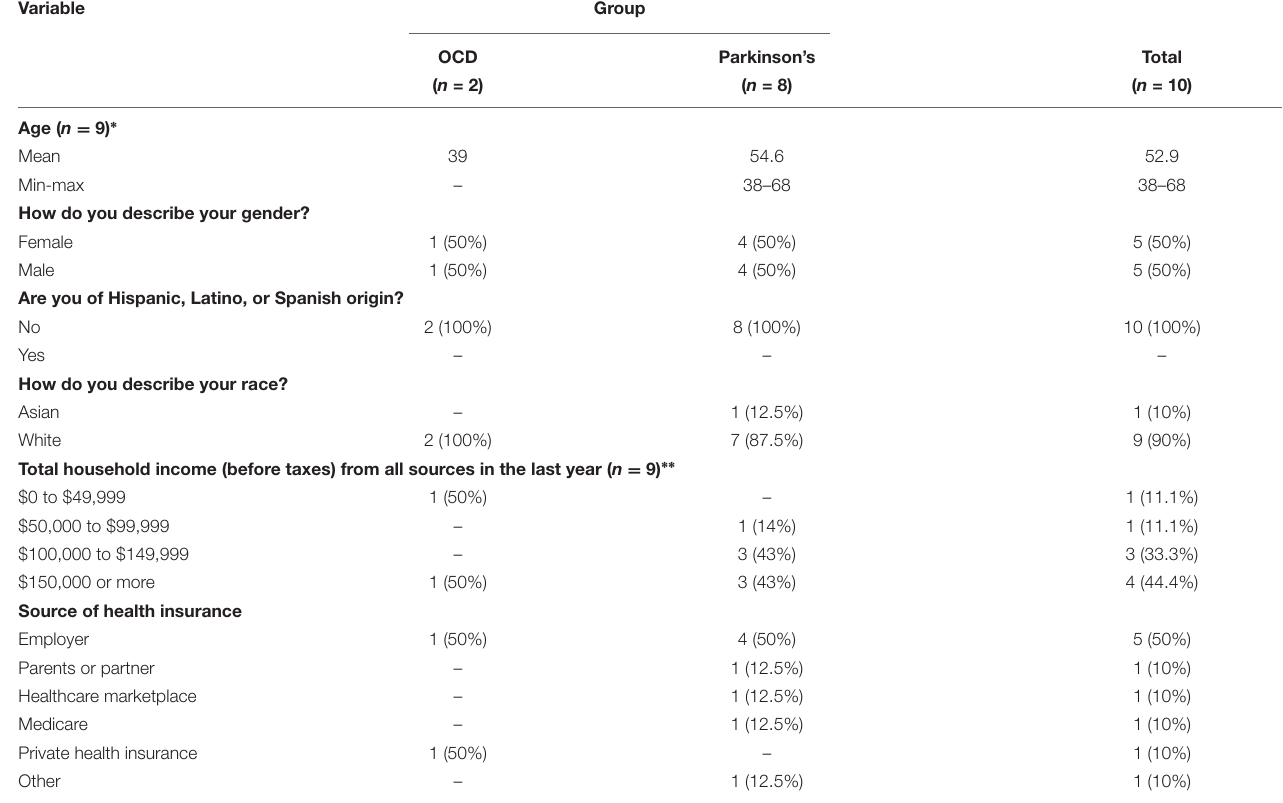
TABLE 3 | Decliner demographics.